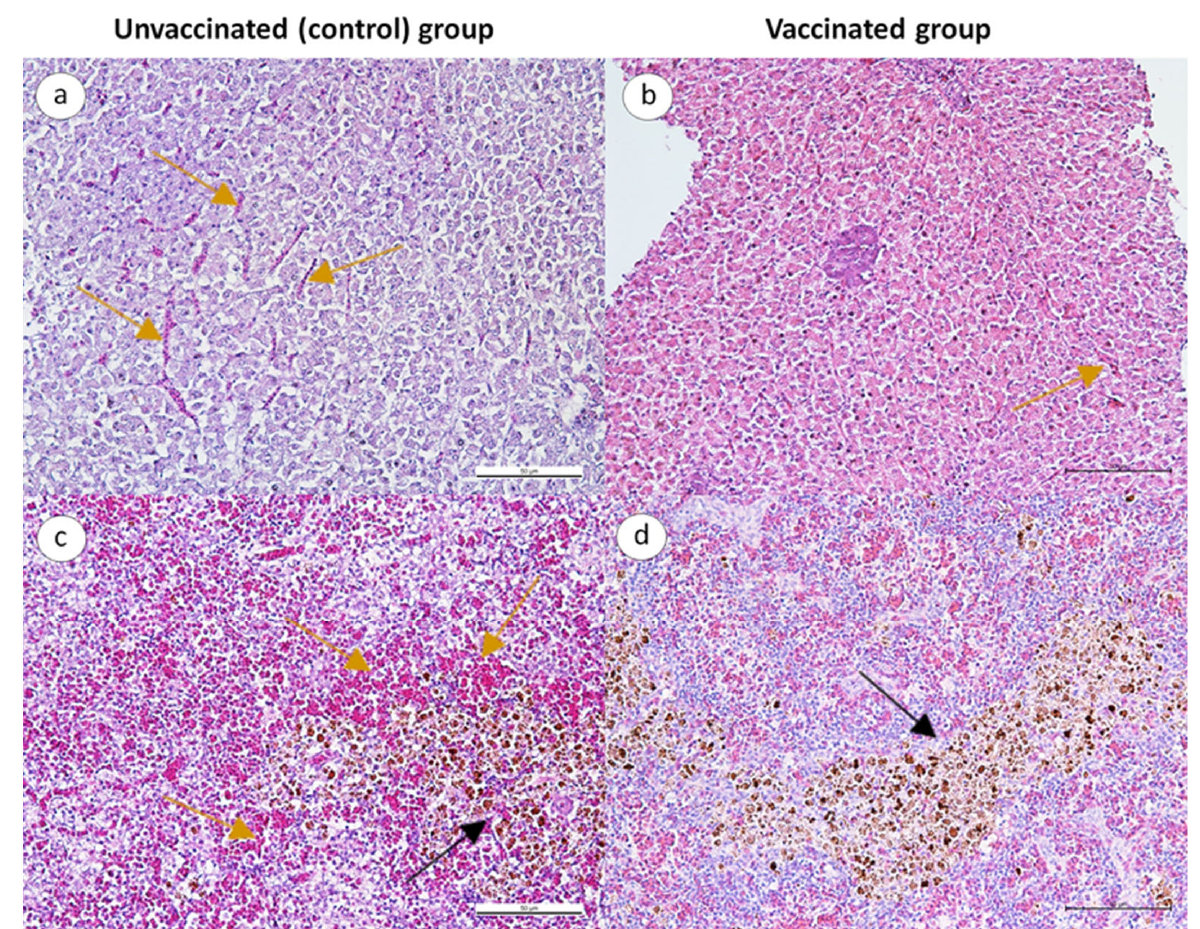
Figure 6. Photomicrograph of the liver and spleen of unvaccinated and vaccinated red hybrid tilapia following challenge with Aeromonas spp. (H & E stain, bar = 50 μ m). ( a ) Vascular congestion (yellow arrow) in the liver of unvaccinated fish. ( b ) Mild congestion in the liver of vaccinated fish. ( c ) Melano ‐ macrophage aggregates (black arrow) and congestion (yellow arrow) in the spleen of unvaccinated fish. ( d ) Melano ‐ macrophage aggregates (black arrow) in the spleen of vaccinated fish.